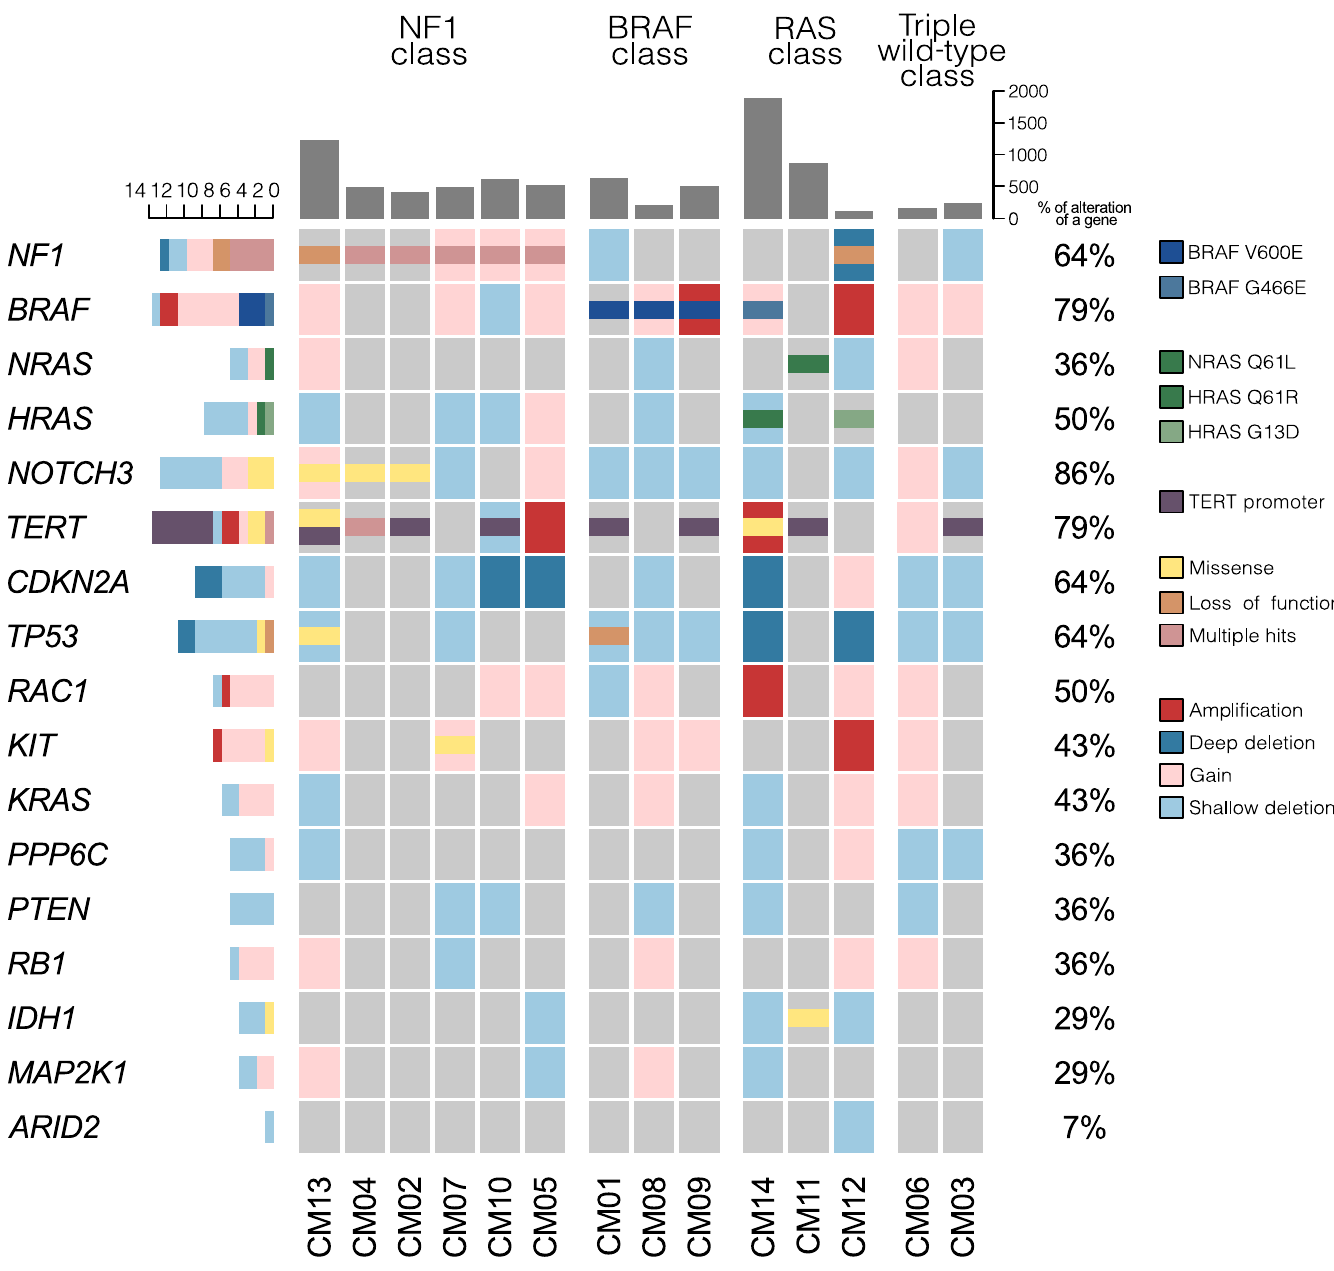
Fig 3. Landscape of single nucleotide and copy number variations in key driver genes in CJM, according to the 4-group genetic classification of CM. Each column represents alterations in 17 known cancer driver genes in one tumor sample; the number of non-neutral coding somatic mutations for each patient is indicated by the grey bars on the top of each column and the frequency of mutation for each gene is shown on the right side of the figure.